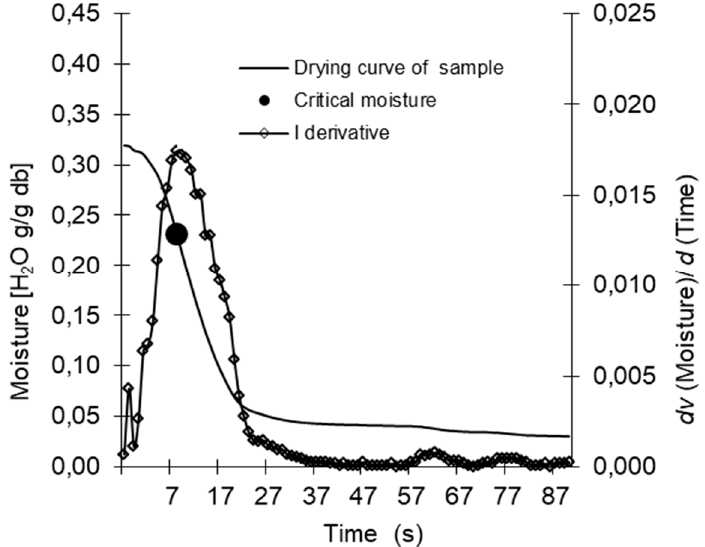
Figure 3. The course of drying sorption curves for native starch.